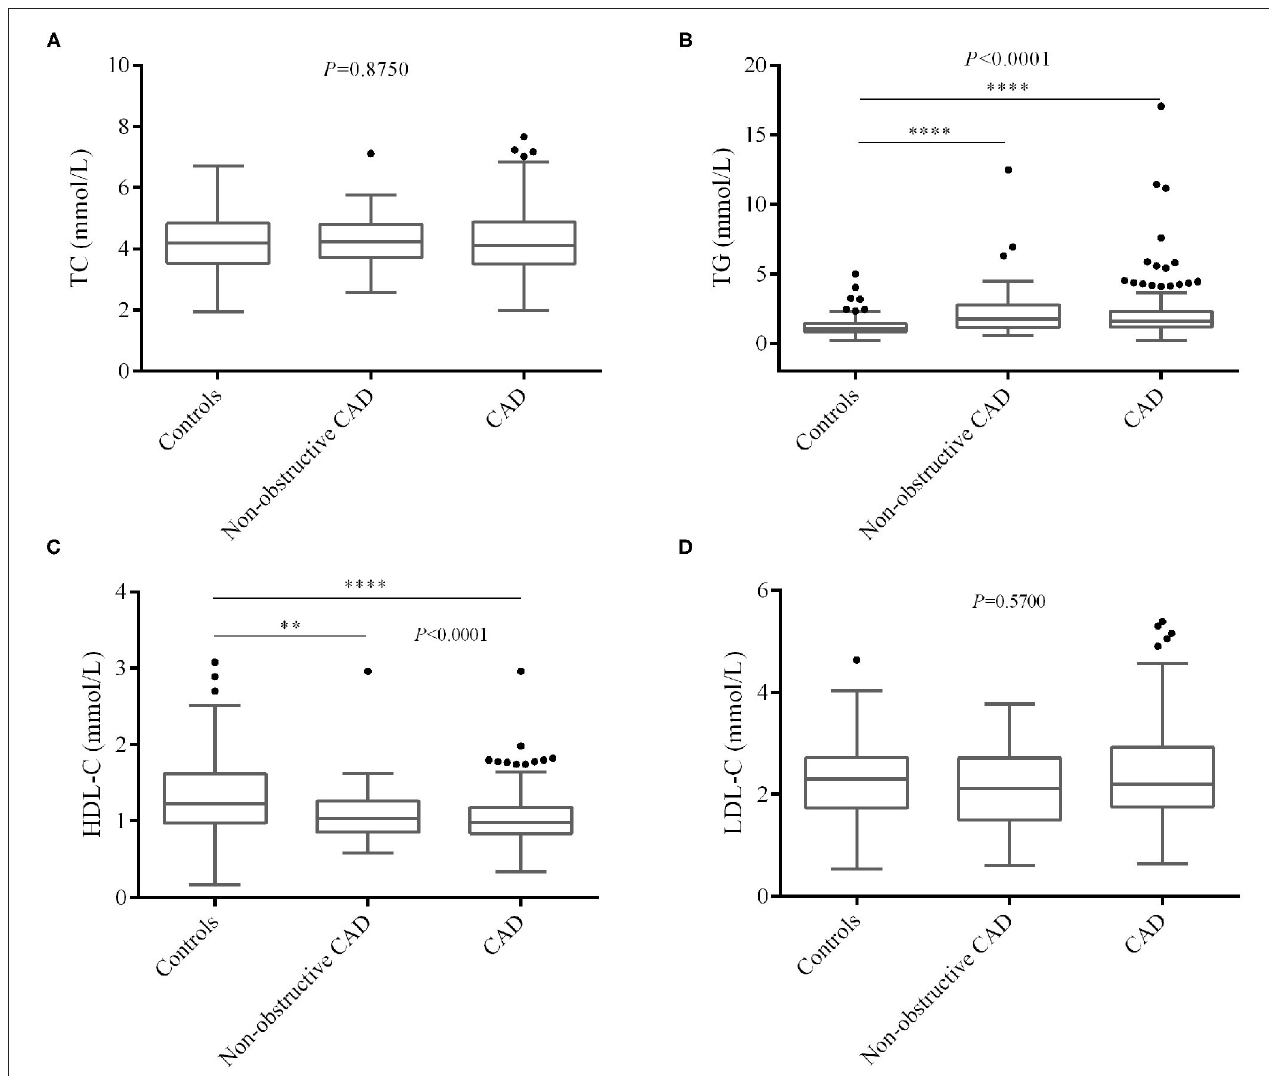
FIGURE 2 | Comparison of blood lipids level among controls and non-obstructive and significant CAD patients. (A) TC, (B) TG, (C) HDL-C, (D) LDL-C. CAD, coronary artery disease; TC, total cholesterol; TG, triglyceride, HDL-C, high-density lipoprotein cholesterol; LDL-C, low-density lipoprotein cholesterol. * P < 0.05, ** P < 0.01, *** P < 0.001, **** P <